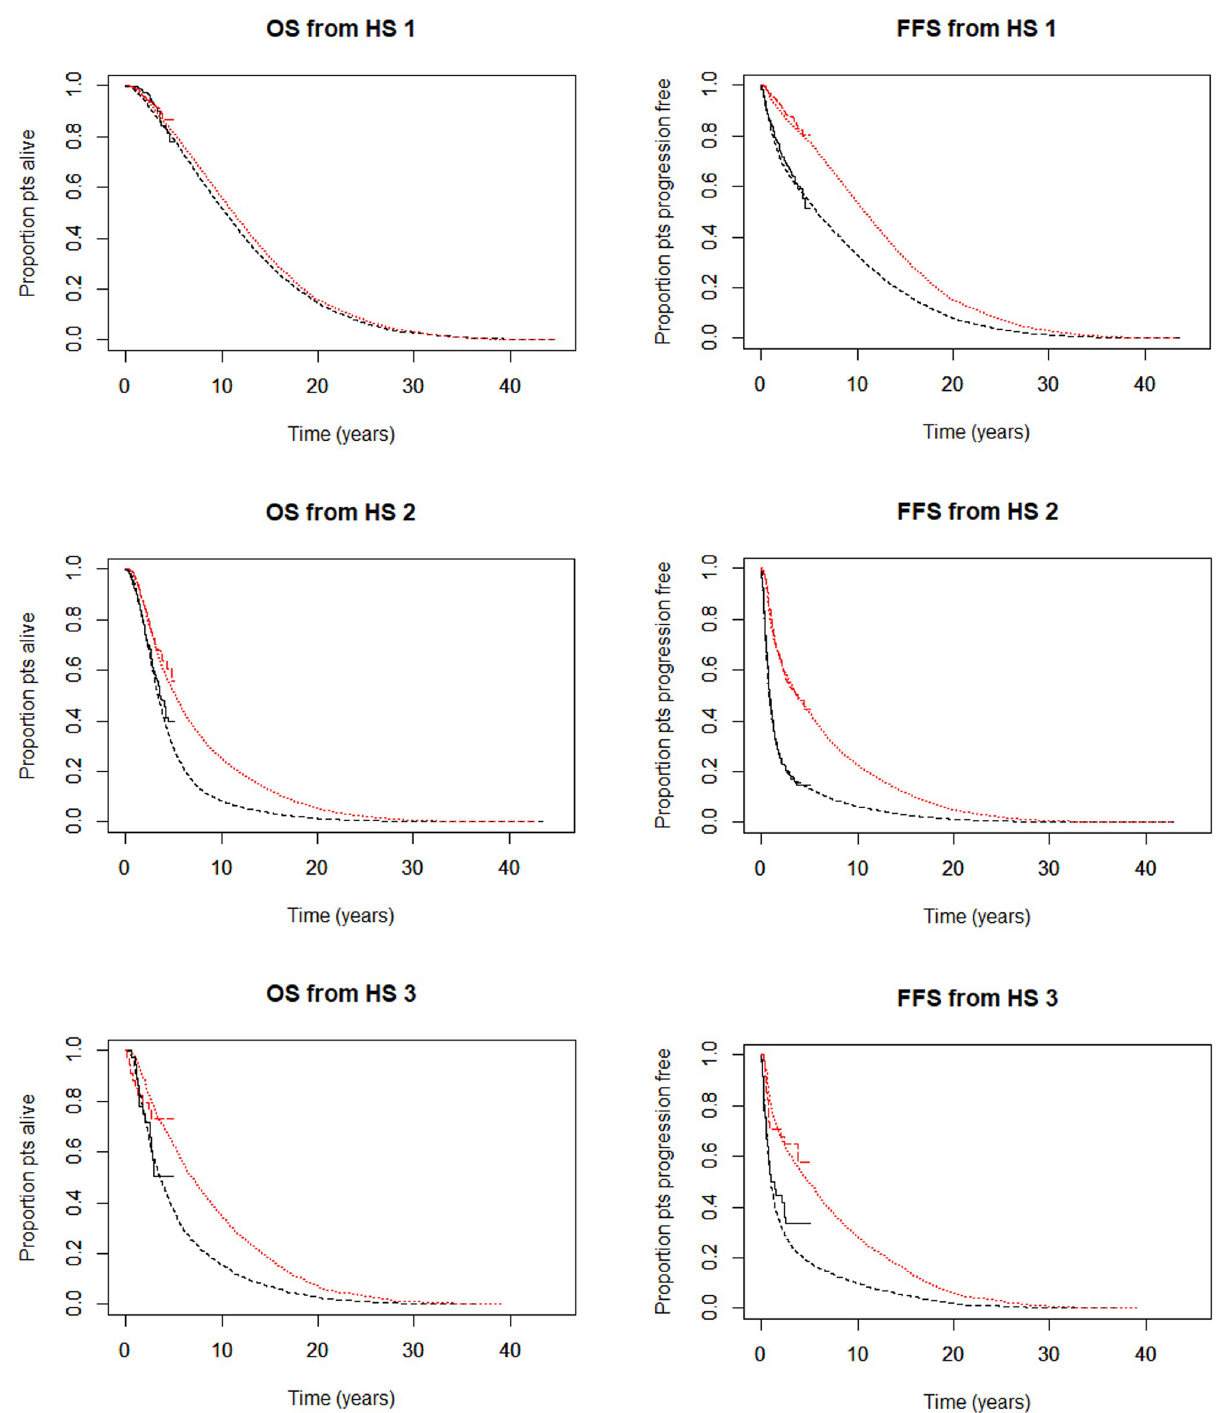
Fig 2. Overall and failure-free survival from each of the three starting health states. Top row: Overall (OS) and failure-free survival (FFS) from HS1, i.e. the M0 subgroup; middle row: OS and FFS from HS2, i.e. M1 patients whose initial metastasis was in bone; bottom row: OS and FFS from HS3, i.e. M1 patients whose initial metastasis was in visceral tissue (not bone). Stepped lines to around 5 years are observed trial data and smooth lines to 45 years are predicted data from the lifetime simulation model. In the lifetime lines, short dashes (red) indicate the AAP+SOC arm, and longer dashes (black) indicate the SOC-only